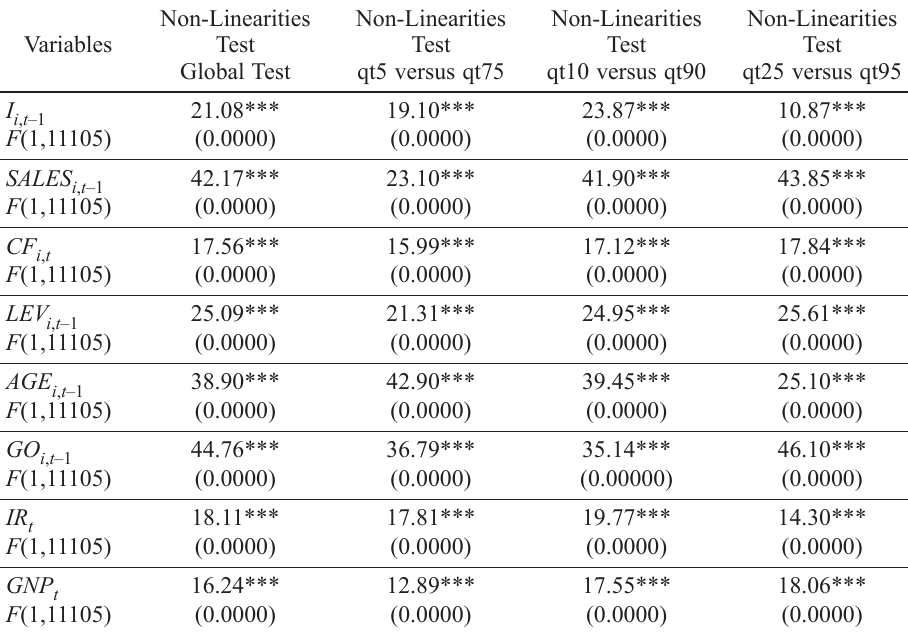
Table 6. Investiment Determinants – Chow